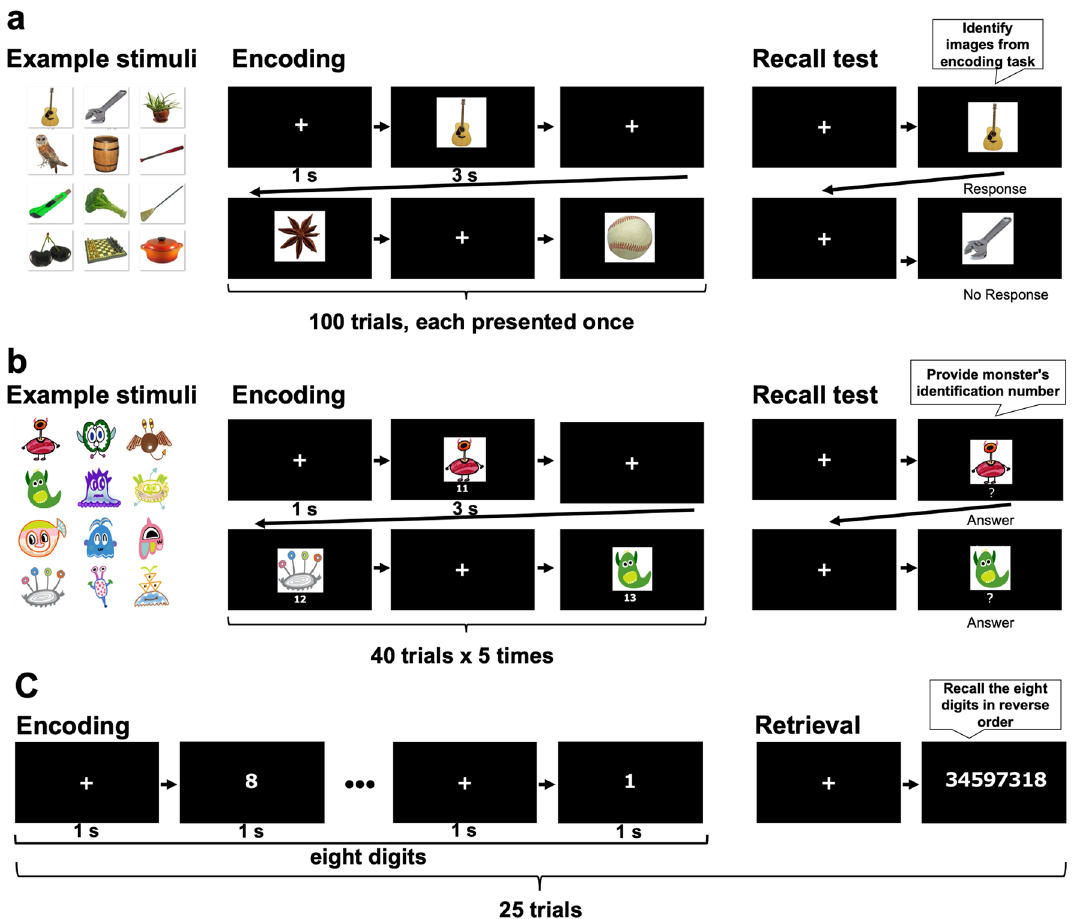
Figure 6. Examples of the memory tasks. ( a ) Episodic memory: In the encoding task, the participants were presented with 100 images. The recall test included 25 images from the encoding task and 75 new images. The participants were asked to identify the 25 images from the encoding task. All pictures were obtained from Mathieu Brodeur 61,62,64 licensed under CC BY-SA 3.0 (https:// creat iveco mmons. org/ licen ses/ by- sa/3. 0/). ( b ) Semantic memory: Participants were presented with 40 images of monsters each paired with a two-digit identification number. The monster and corresponding identification number were presented five times during the encoding task. The recall test included ten monsters from the encoding task. Participants were asked to provide the identification numbers of the monsters in the recall test. All illustrations were drawn using Tayasui Sketches (https:// tayas ui. com). ( c ) Working memory: In each trial of the encoding task, participants were presented with eight digits. Each digit was presented for 1 s. In the recall test, participants were asked to recall the eight digits in reverse order. This task included 25 trials. This figure was drawn using Microsoft PowerPoint for Mac (version